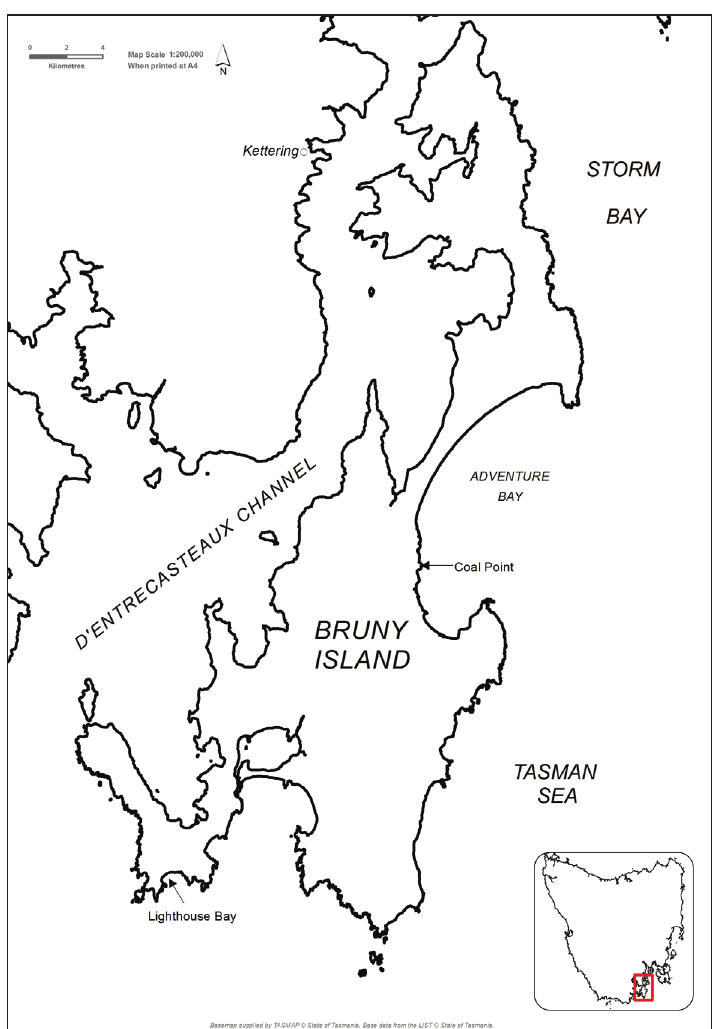
Figure 13. Distribution